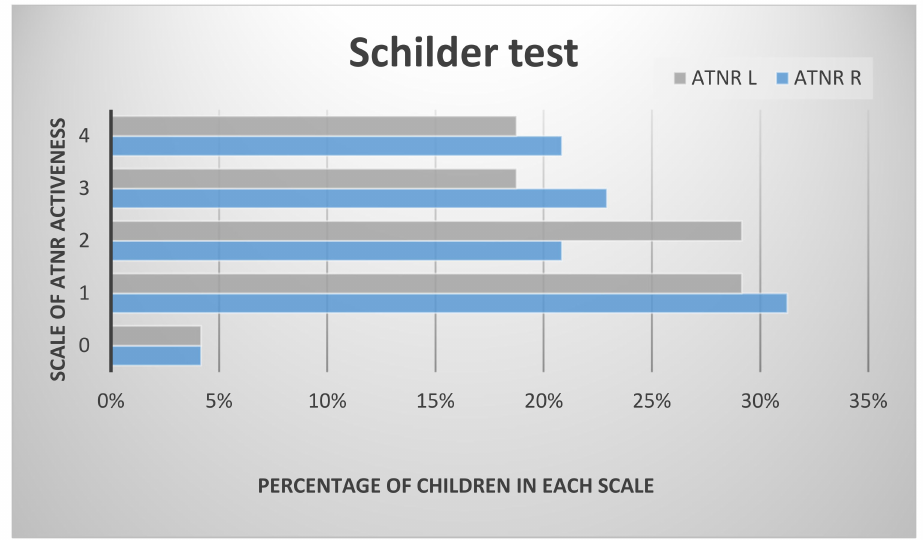
Figure 2. The results of ATNR in the examined group in the Schilder test.